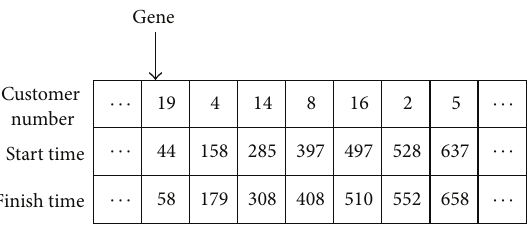
Figure 1: Representation of each